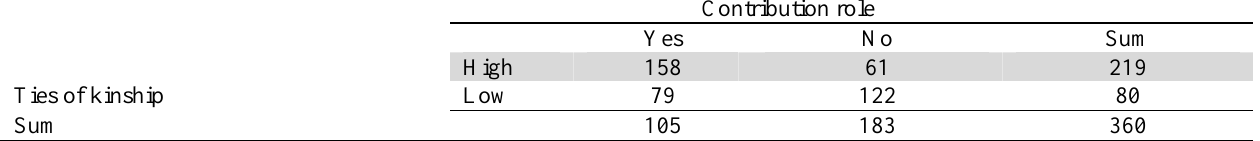
The relationship between women’s ties of kinship and their contribution role on society